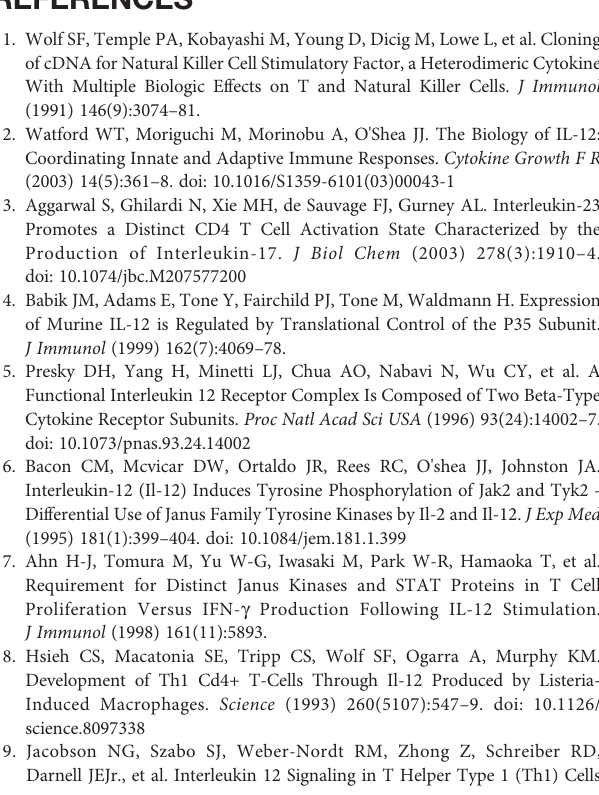
(D) WB analysis of rgcIl-12BB digested by glycosidase. The MW of glycosidase (PNGase F) is 36 kDa. Supplementary Figure 9 | Effects of rgcIl-12BB on ifn- g mRNA expression in grass carp HKLs. HKLs were treated with 1000 ng/mL of rgcIl-12BB for 1, 6, 12 and 24 h, separately. The mRNA expression of ifn- g was detected by RT-qPCR, and the relative mRNA levels were normalized by b -actin and expressed as fold changes compared with the control group of each time point. ** p < 0.01, and *** p < 0.001. Data are shown as mean ± SEM (N = 4). Supplementary Figure 10 | The speci fi city of anti-gcIfn- g pAb was validated by Western blotting. (A) SDS-PAGE analysis of rgcIfn- g . (B) Western blotting analysis by using anti-gcIfn- g pAb (1:1000 diluted). (C) Western blotting analysis by using anti-gcIfn- g pAb (1:1000 diluted) pre-absorbed with 3 m g of rgcIfn- g . Supplementary Figure 11 | The gcIfn- g competitive-inhibition ELISA standard curve. (A) The original data of gcIfn- g competitive-inhibition ELISA standard. The inhibition ratio was calculated by the formula: Inhibition ratio = 100% × [OD450 (0 ng/mL) - OD450 (other concentration)]/OD450 (0 ng/mL). (B) The standard curve was drawn according to the inhibition ratio and the corresponding protein concentrations. Supplementary Figure12 | EffectsofrgcIl-12isoformson il-17a/f1 and il-22 mRNA expression in grass carp monocytes/macrophages. Grass carp monocytes/ macrophagesweretreatedwith30-1000ng/mLrgcIl-12AB (A,B) orrgcIl-12BB (C,D) for 12 h. The mRNA expression of il-17a/f1 and il-22 was detected by RT-qPCR and the relative mRNA levels were normalized by b -actin and expressed as fold changes compared with the control group. Data are shown as mean ± SEM (N=4). The “ n.s. ” indicates no signi fi cant. Supplementary Table 1 | The primers used in the present study. Supplementary Table 2 | QMEANDisCo Global score of the predicted